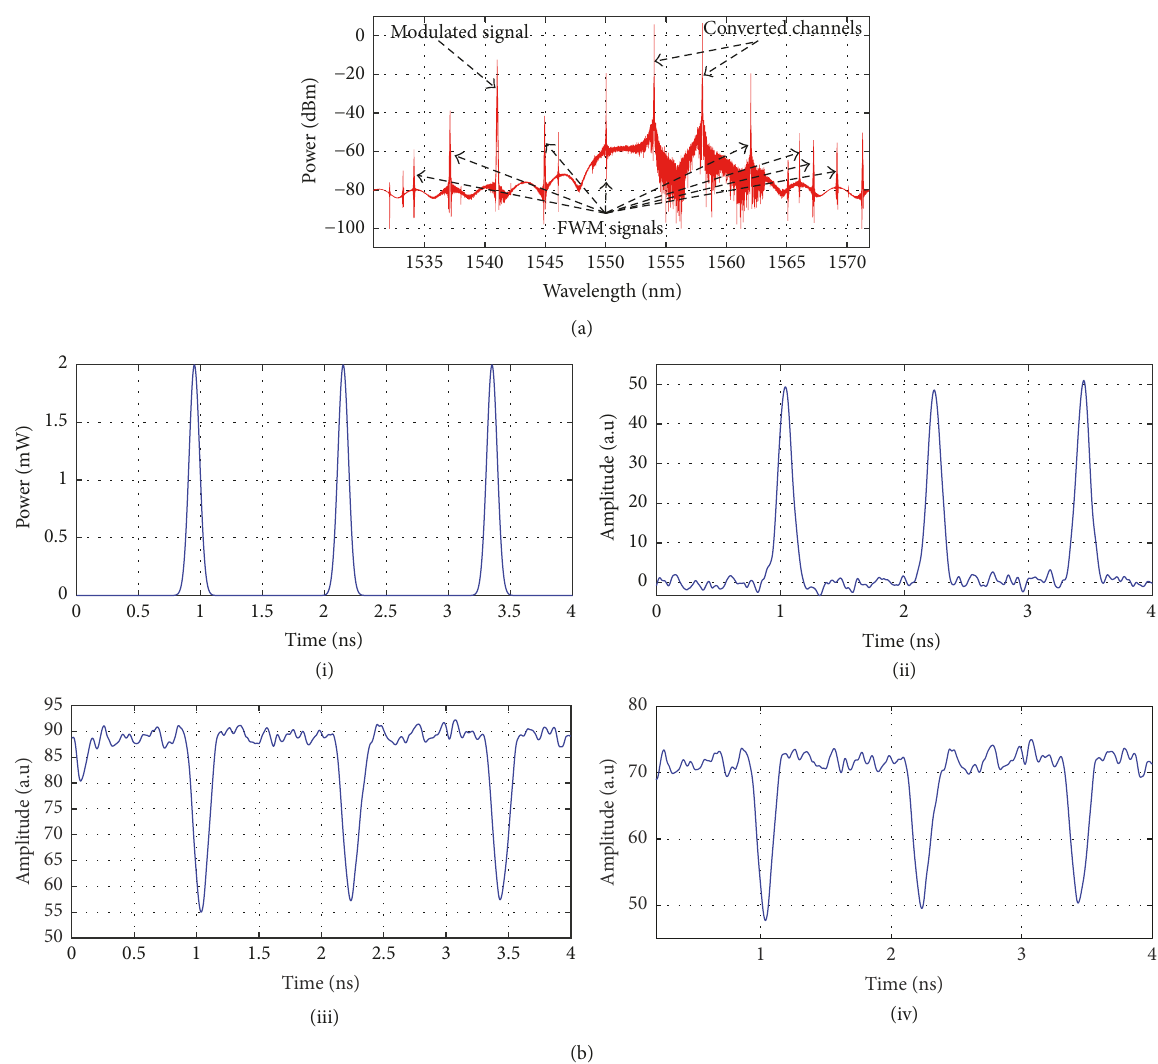
Figure 2: SOA output shape. (a) The TW-SOA output spectrum and (b) representation of wavelength converter.